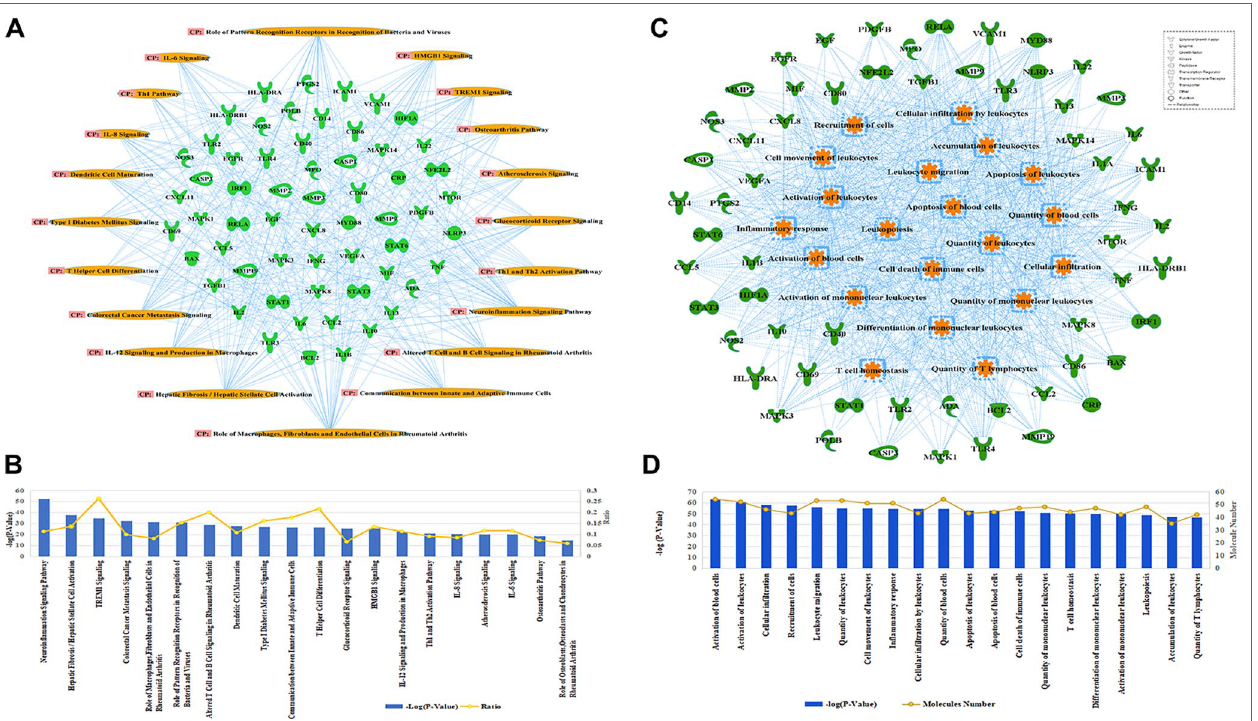
FIGURE 4 | Functional and pathway analysis of potential XBJ targets in fungal infection. (a , B) Pathway analysis of XBJ targets in fungal infection. (a) The relationships of potential XBJ targets and top 20 related pathways. (B) The ranking of the top 20 signaling pathways of potential XBJ targets was presented. The top 20 signaling pathways of potential XBJ targets in fungal infection were ranked from left to right by –log ( P value). (C , D) Functional analysis of XBJ targets in fungal infection. (C) The target-function network was presented with the top 20 functions marked in saffron yellow. (D) The ranking of the top 20 functions of potential XBJ targets was presented. The top 20 related functions were ranked from left to right by –log ( P value).